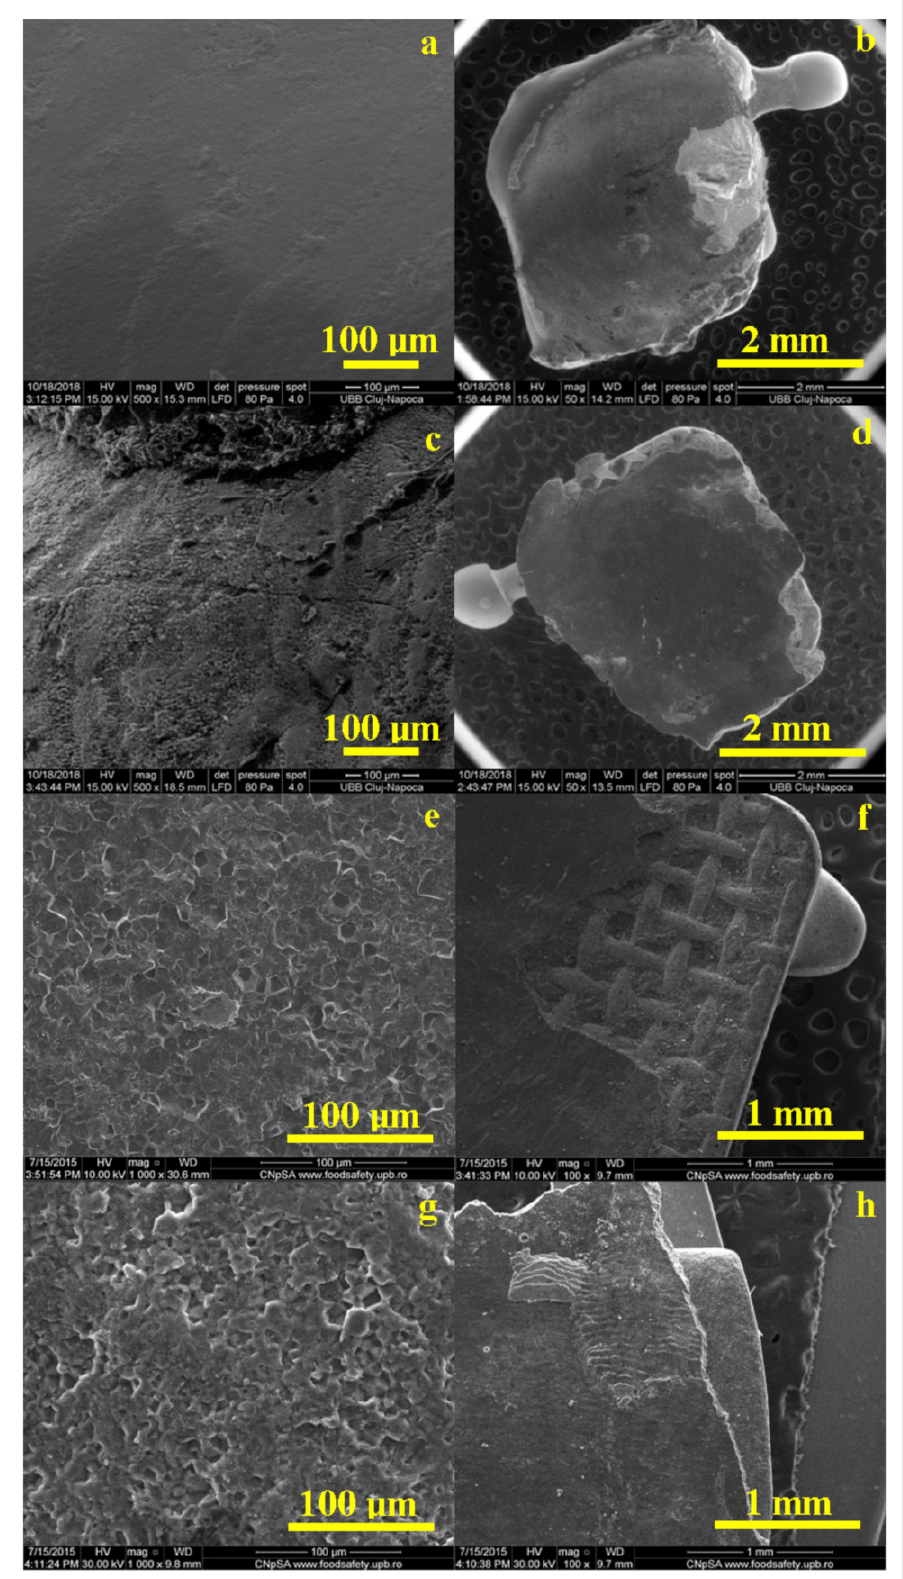
Figure 6. Representative SEM images of the enamel and bracket surface after debonding for all tested orthodontic adhesives: Blugloo ( a , b ); Light Bond ( c , d ); Opal Seal ( e , f ); experimental material C1 ( g , h